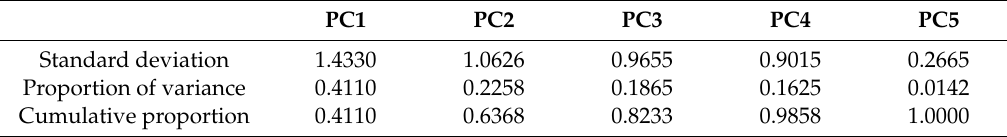
Table 1. PCs with standard deviation, proportion of variance and cumulative proportion.